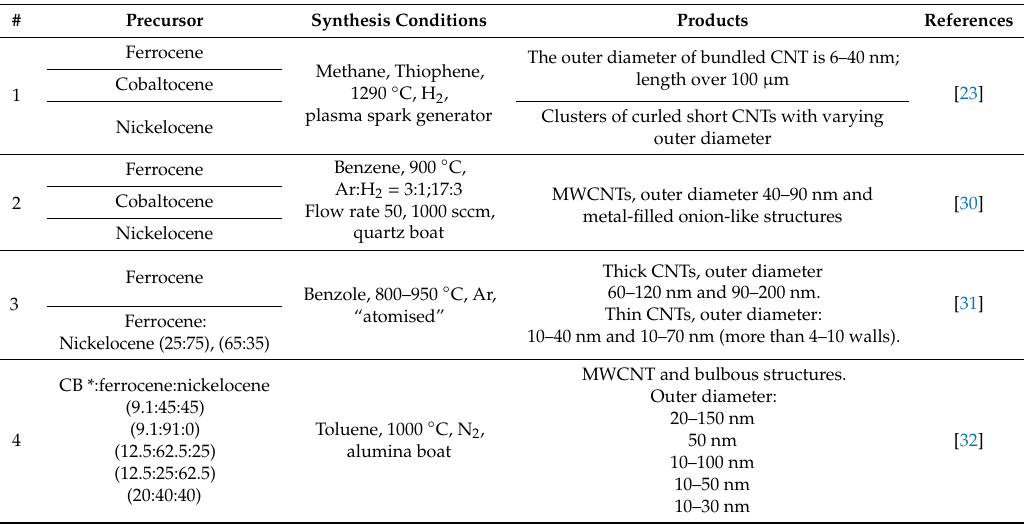
Table 1. Experimental conditions and properties of carbon nanotubes obtained on metallocene catalysts Fe, Co and Ni by aerosol